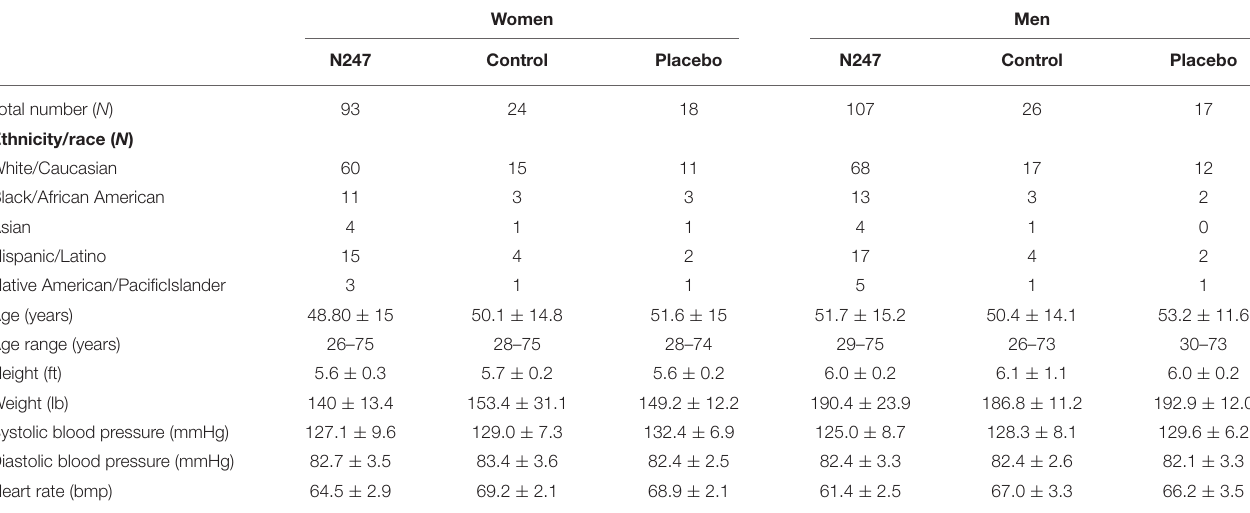
TABLE 2 | Subject